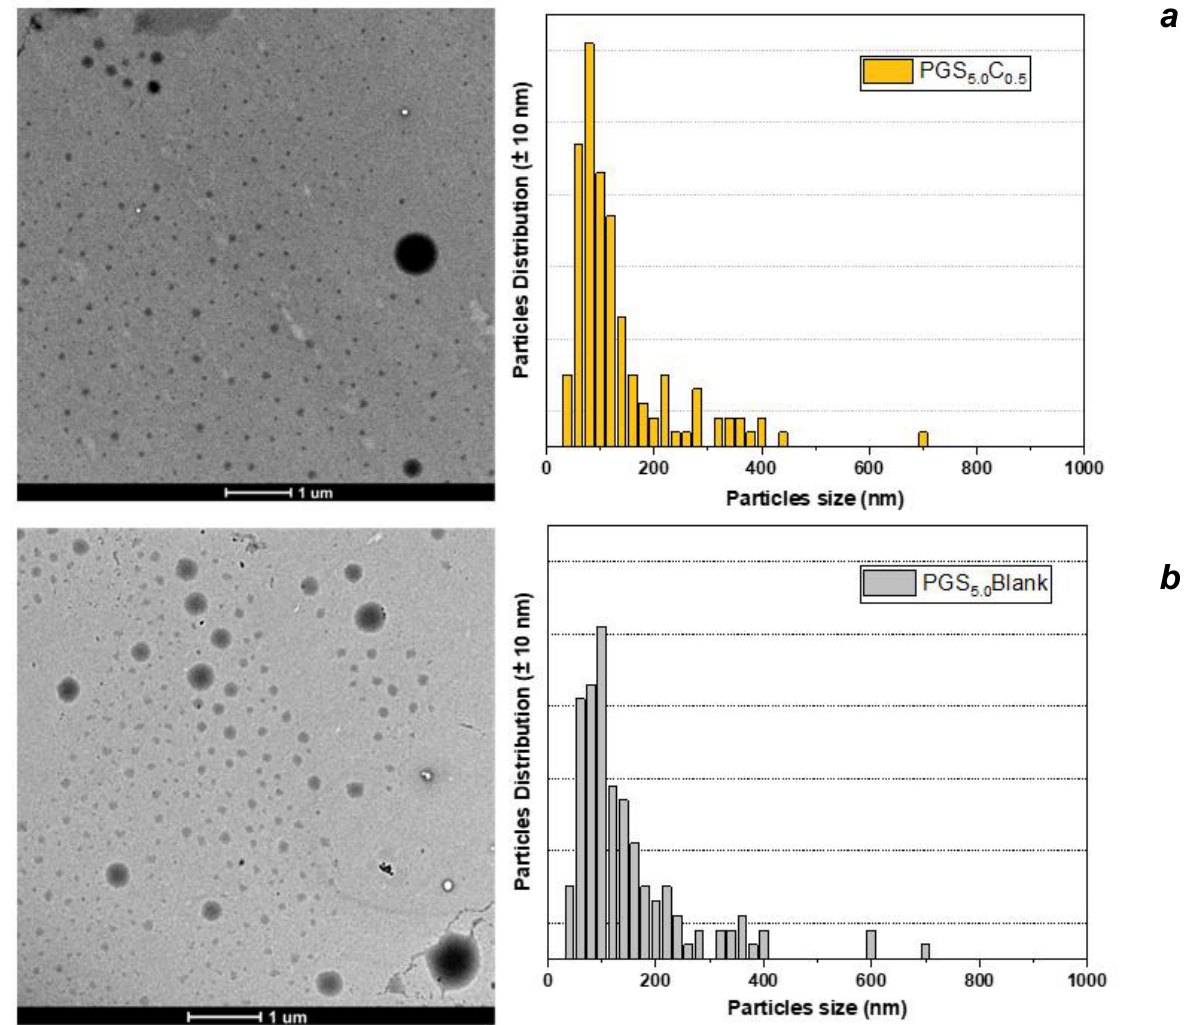
Figure 5. PGS 5.0 C 0.5 ( a ) and PGS 5.0 Blank ( b ) TEM images and relevant size distribution graphs calculated from TEM